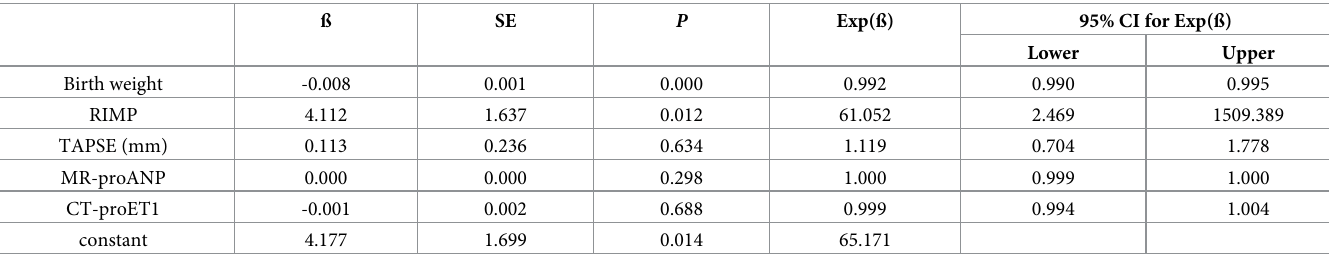
Table 4. Impact of birth weight, RV function parameters and vasoactive peptides on logistic regression to estimate risk for